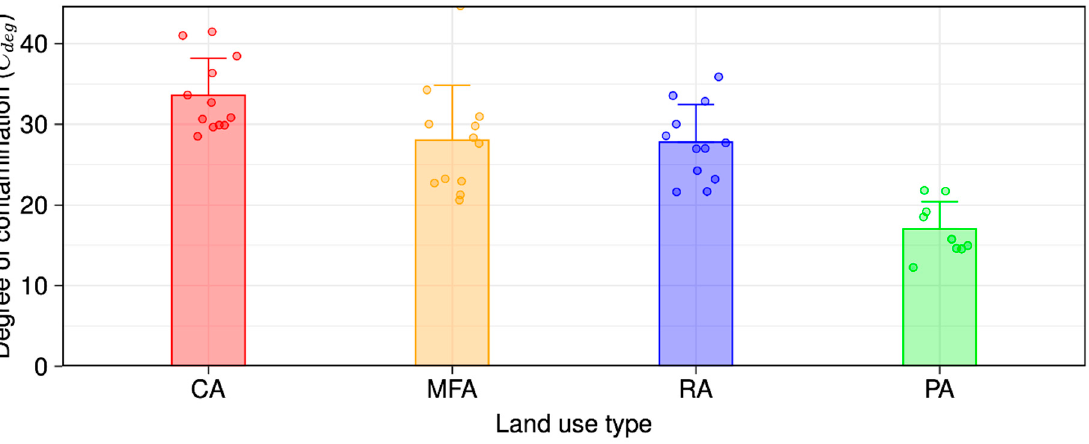
Figure 8. Degree of contamination ( C deg ) in road dust in different land use areas of Mymensingh City. CA = commercial areas, MFA = medically facilitated areas, RA = residential areas, PA = park areas.